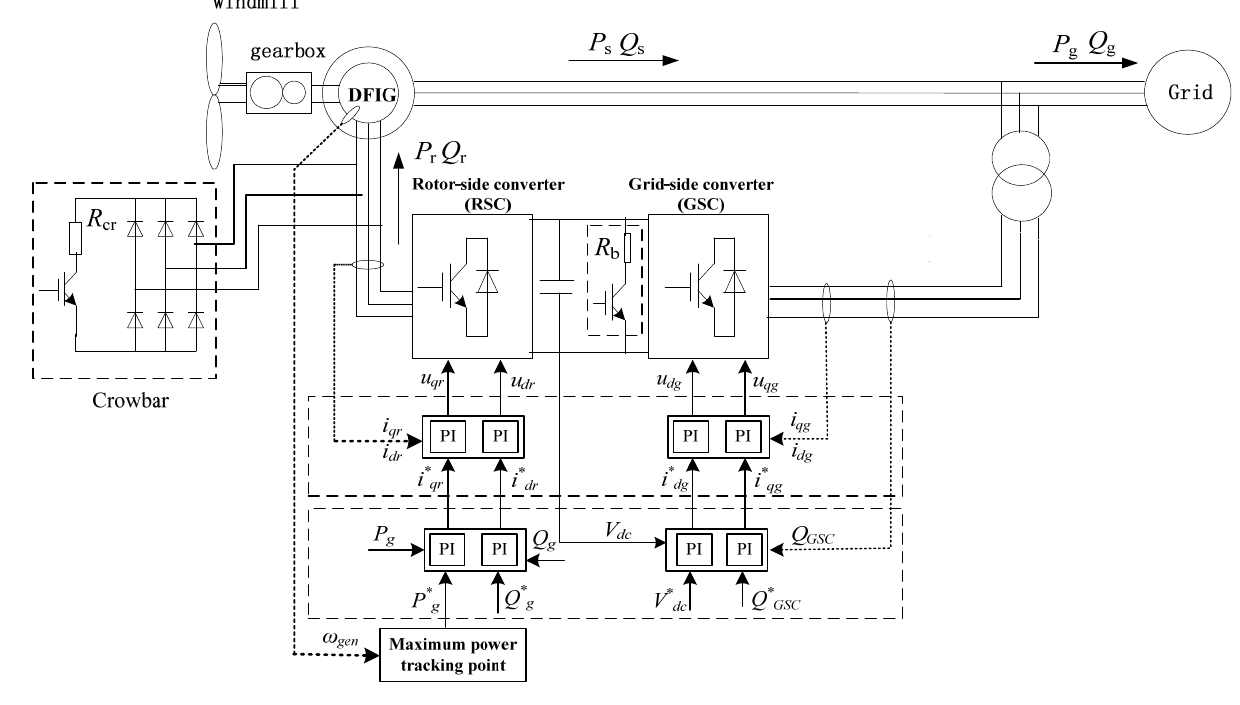
Figure 2. Schematic of the DFIG wind turbine.